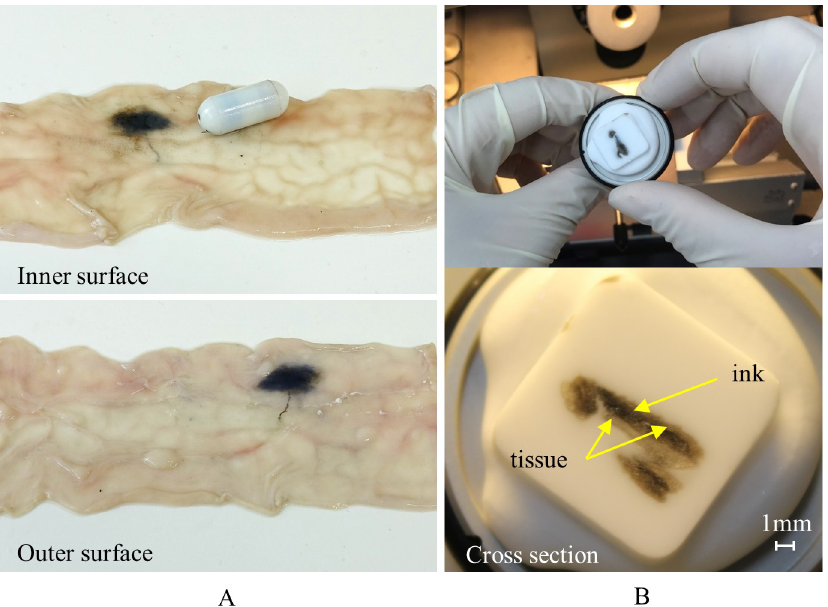
Fig 15. Tattooed tissue verification. (A) Inner and outer surfaces of the tattooed intestine. (B) Cross-section inspection of the dyed tissue.